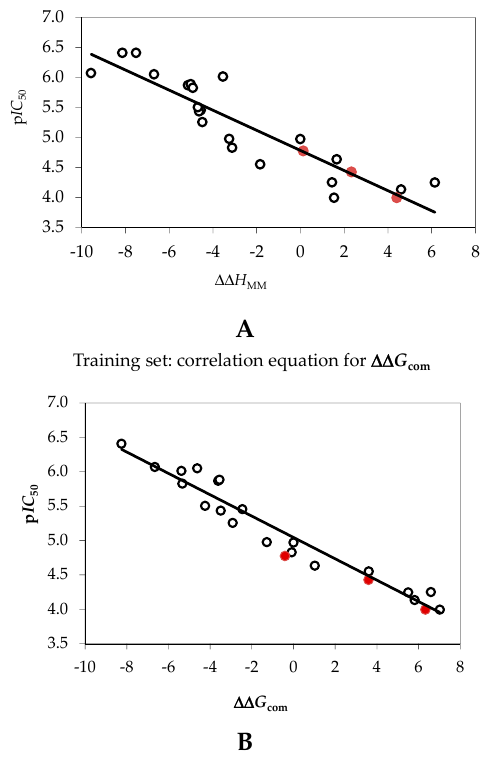
Figure 4. ( A ) Plot of correlation equation between p IC 50 and relative enthalpic contribution to the Gibbs free energy of InhA-PCAMx complex formation (Equation (6)) ΔΔ H MM ; ( B ) Similar plot for relative complexation Gibbs free energies of the InhA-PCAMx complex formation ΔΔ G com of the training set, all in kcal·mol − 1 . The data for the validation set are shown in red color; the black circles represent PCAMs from the training set.